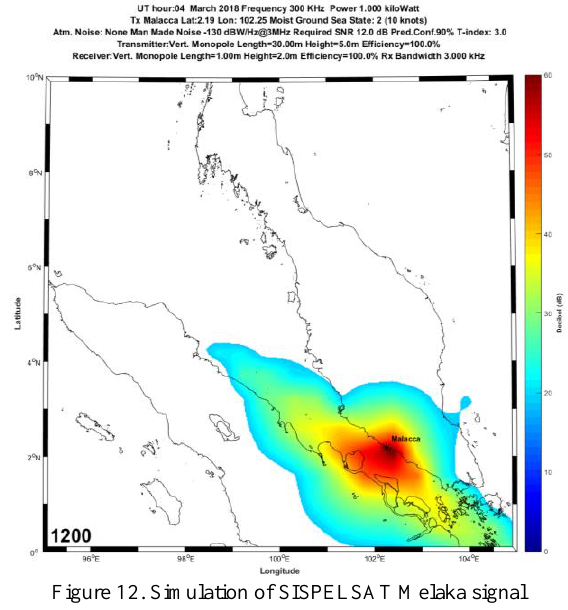
Figure 12. Simulation of SISPELSAT Melaka signal